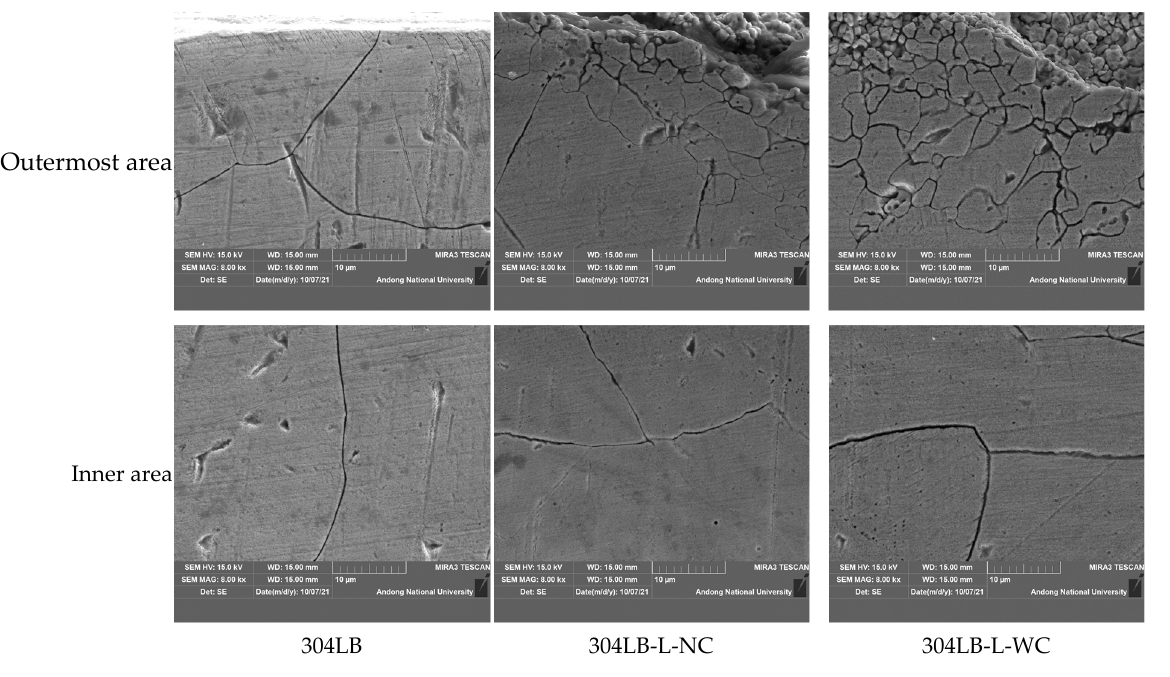
Figure 7. Corroded grain boundaries (SEM, ×8000) in the cross-section of 304L stainless steel after the immersion test for 15 h in a boiling 65% HNO 3.